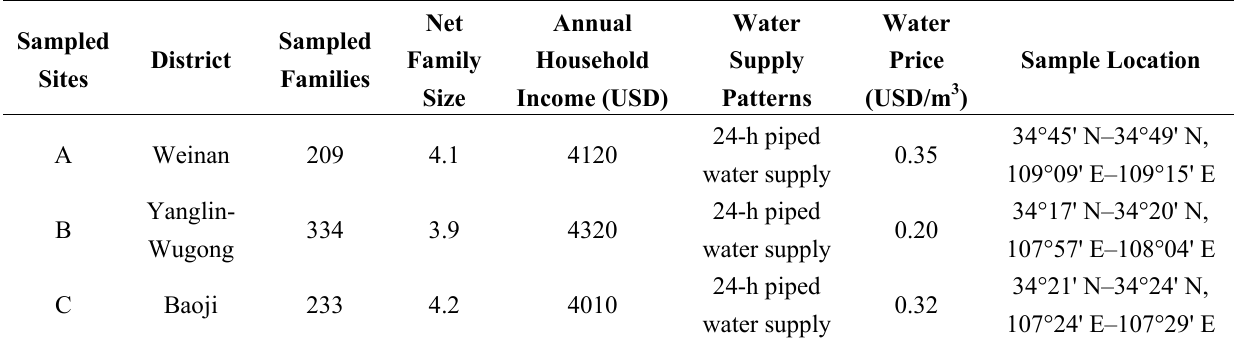
Table 1. Demographic characteristics of the sampled families.